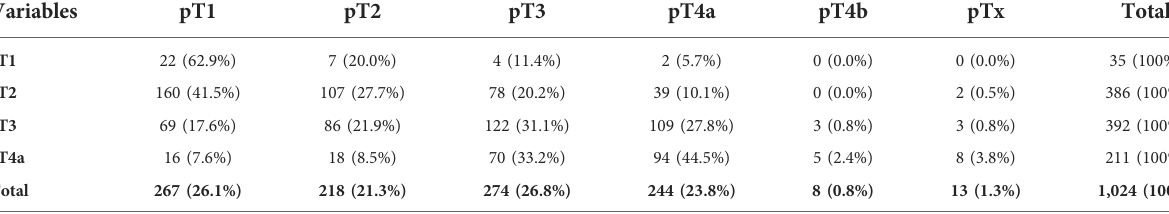
TABLE 1 Discrepancy between clinical T by computed tomography and pathologic